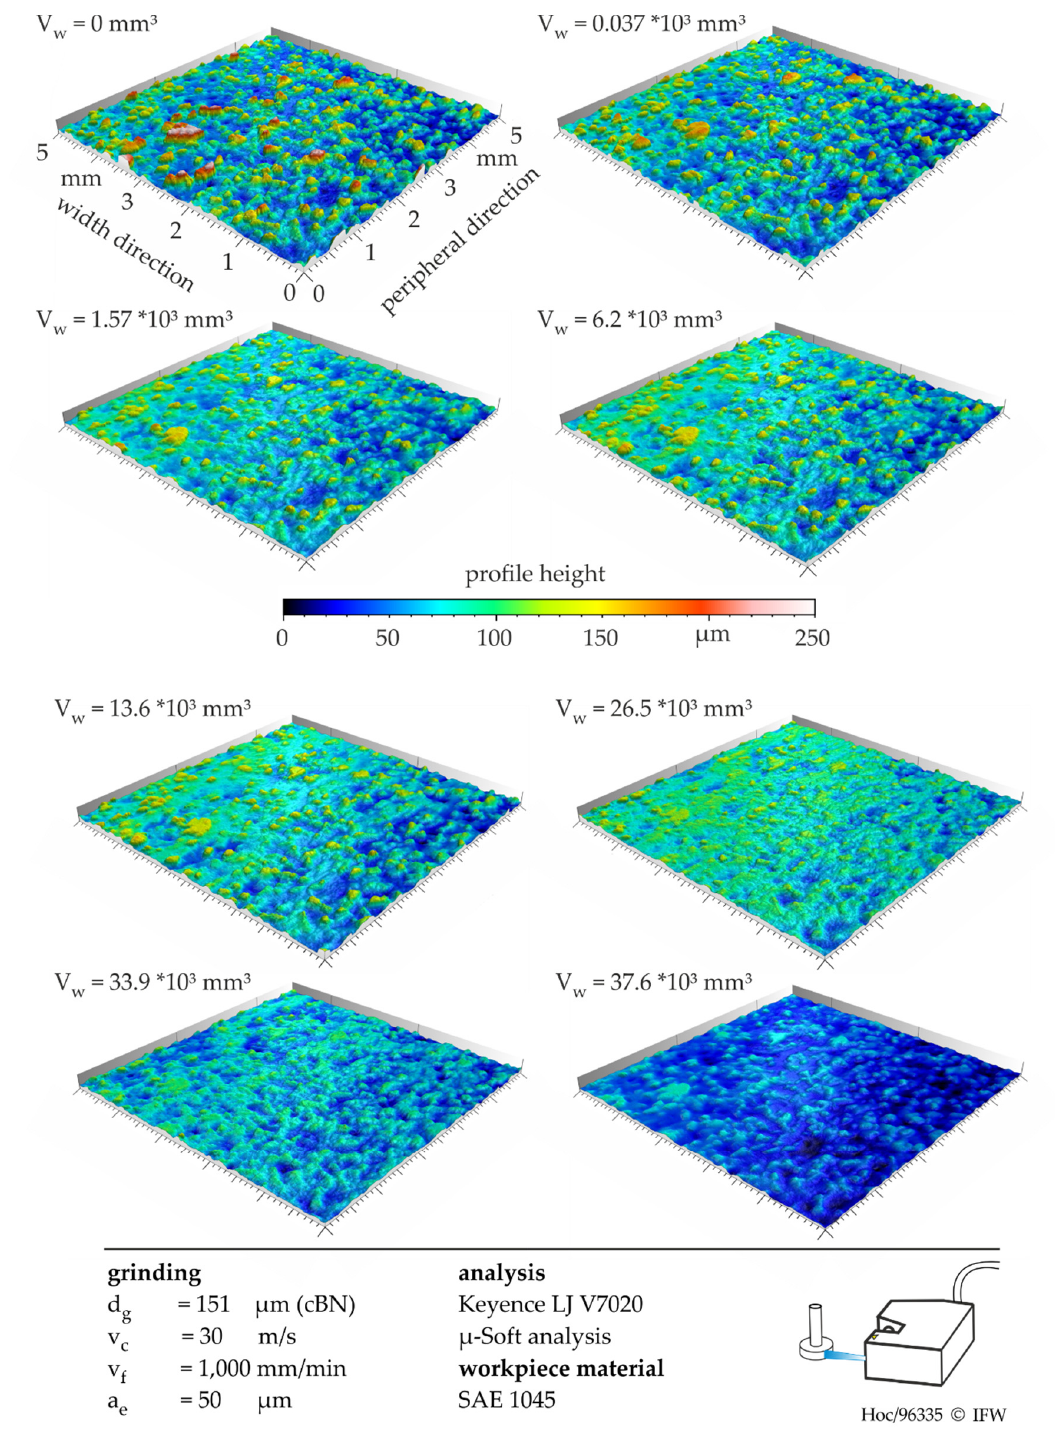
Figure 4. Detailed tool topography during wear investigations.